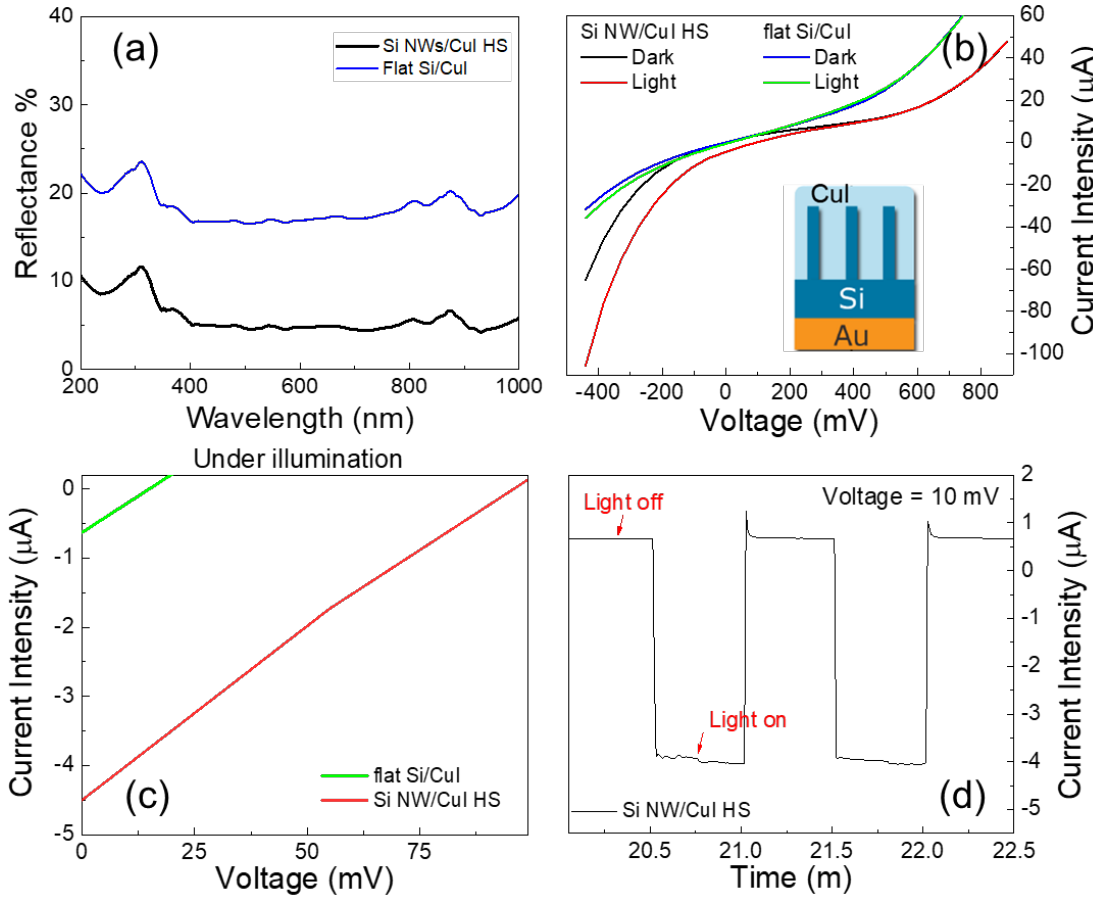
Figure 5. ( a ) Reflectance measurements of flat Si /CuI and Si NWs/CuI junctions are reported in blue and black, respectively ( b ) I-V characteristic of both Si/CuI and Si NWs/CuI n-p heterojunction investigated under dark and light illumination conditions. The inset shows the schematic of the Si NWs/CuI device contacting during the I-V characterization. ( c ) PV output characteristic of the n-p Si/CuI and Si NWs/CuI devices tested under light illumination are show in green and red, respectively. ( d ) Current intensity measured in the device biased at 10 mV under dark/light pulses modulated by intervals of 25 s.